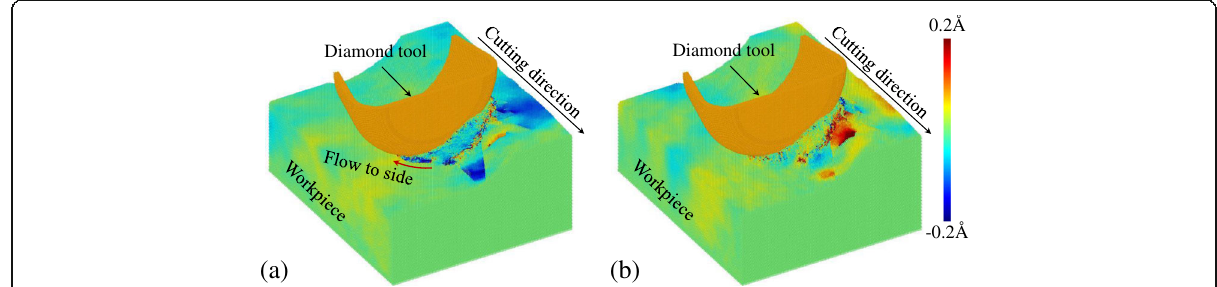
Fig. 9 Displacement of atoms at ( a ) x-direction and ( b ) y-direction at cutting direction of {111} < 11 – 2 > and feed of 1.5